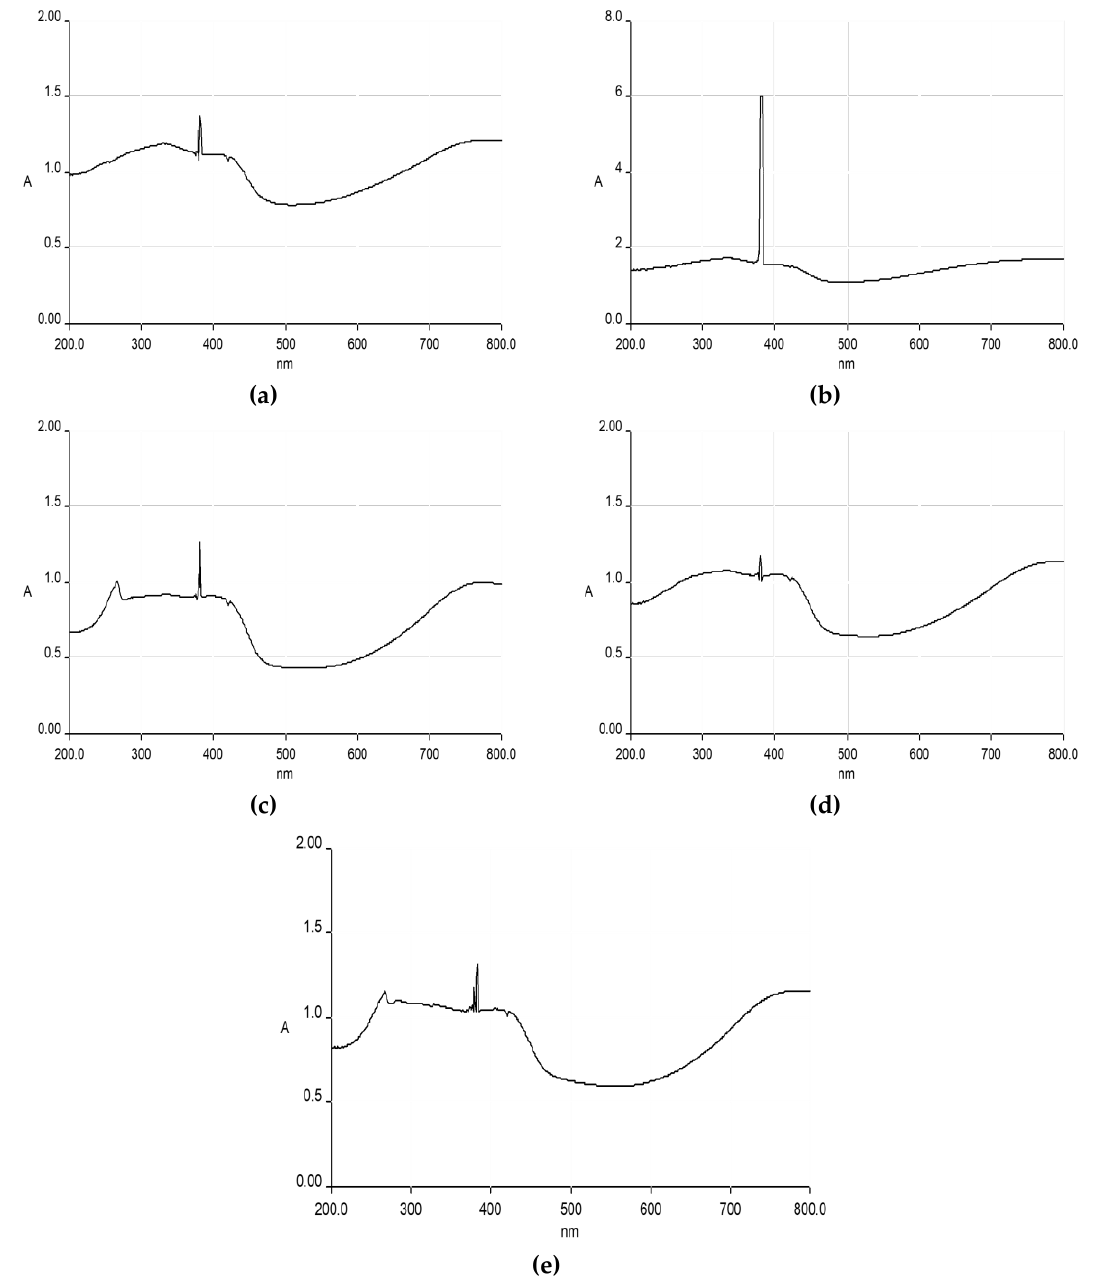
Figure 3. UV – vis: ( a ) 2% MMT/POA; ( b ) 4% MMT/POA; ( c ) 6% MMT/POA; ( d ) 8% MMT/POA; ( e ) Figure 3. UV–vis: ( a ) 2% MMT/POA; ( b ) 4% MMT/POA; ( c ) 6% MMT/POA; ( d ) 8% MMT/POA; 12% MMT/POA. ( e ) 12%